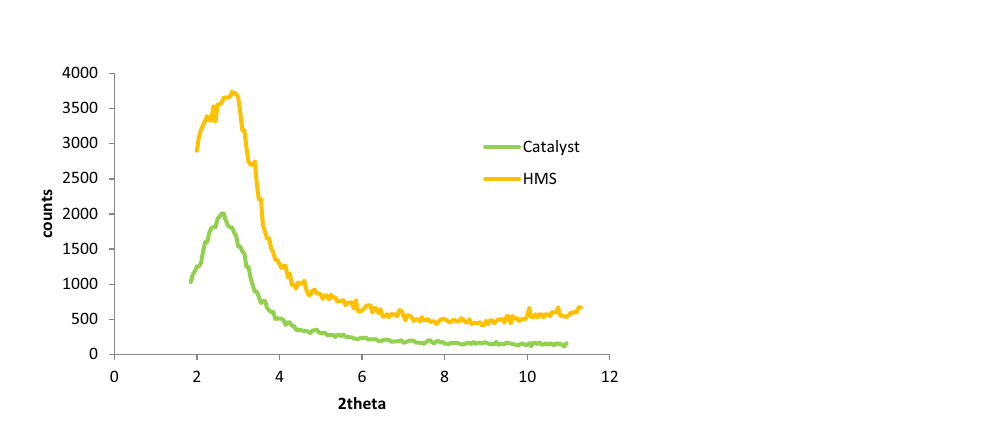
Figure 13. XRD pattern of HMS and